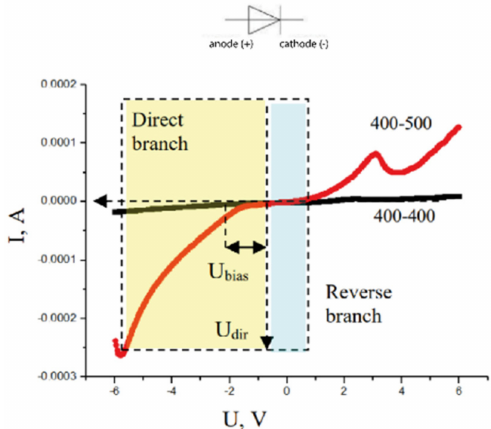
Figure 4. A V - I curves of contacts of chemically identical samples (ZrO 2 —3 mol% Y 2 O 3 ) with identical size of particles (curve 400–400) and samples with different size of particles (curve 400–500) at humidity